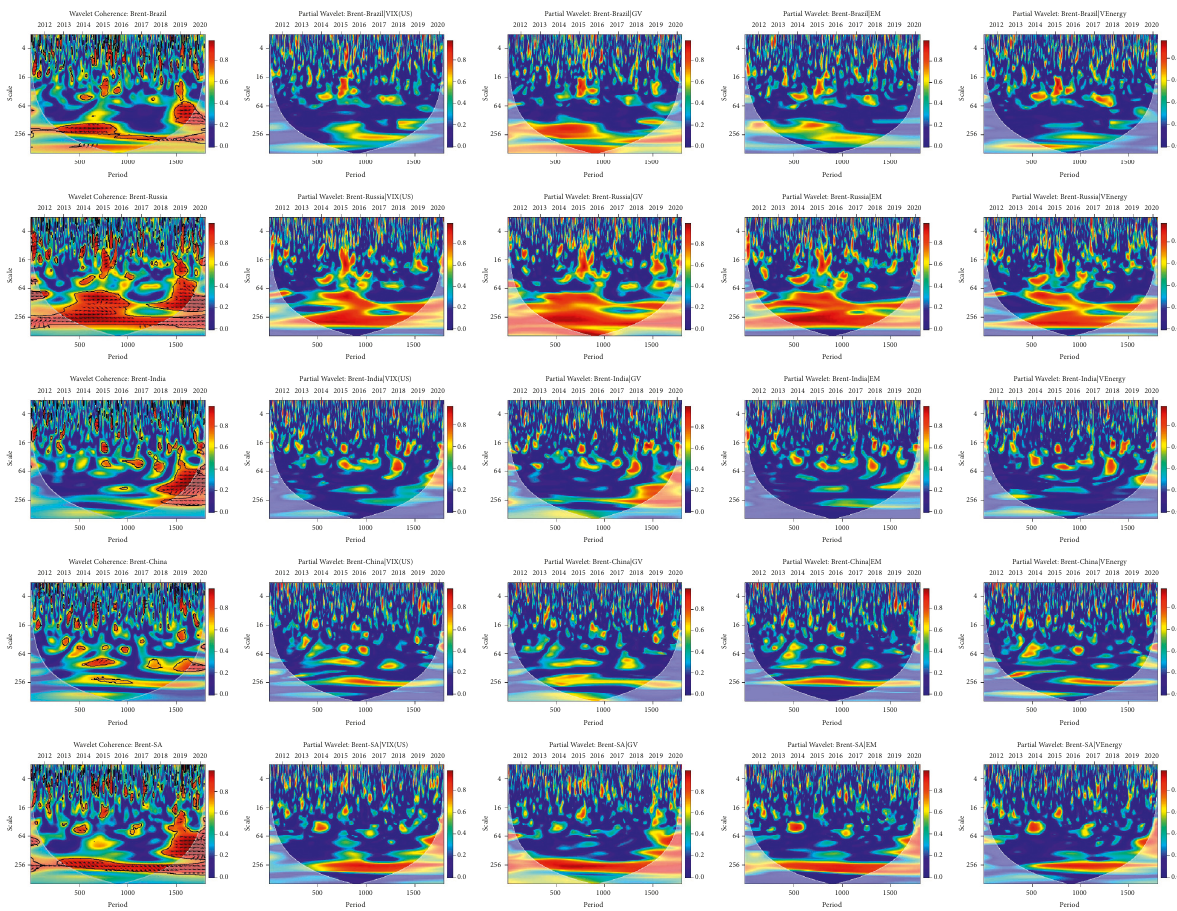
Figure 3: Comovements among Brent crude oil, BRICS, and volatility pointing arrows indicate whether the variables are moving in the same direction or in the opposite direction, respectively. The first variable is shown by right-pointing arrows upwards and left-pointing arrows downwards. Left-pointing arrows upwards and right-pointing arrows downwards, on the other hand, imply that the second variable leads. The surface color represents the degree of comovement between the matched series. The warm color denotes parts with a lot of interac- tions, whereas the cool color denotes regions with less in- teractions [14]. The region outside the cone of influence is insignificant. This is because they are beyond the 95% confidence level. Analyses are displayed for the short-,